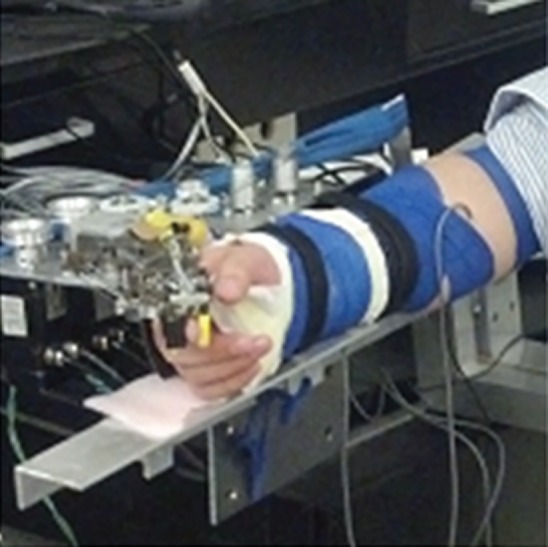
Finger connected to Cable-Actuated Finger Exoskeleton device for performing the experiments. Motors are located off the splinted hand and wrist such that they can be supported by an external structure, the TA-WREX (21, 22).